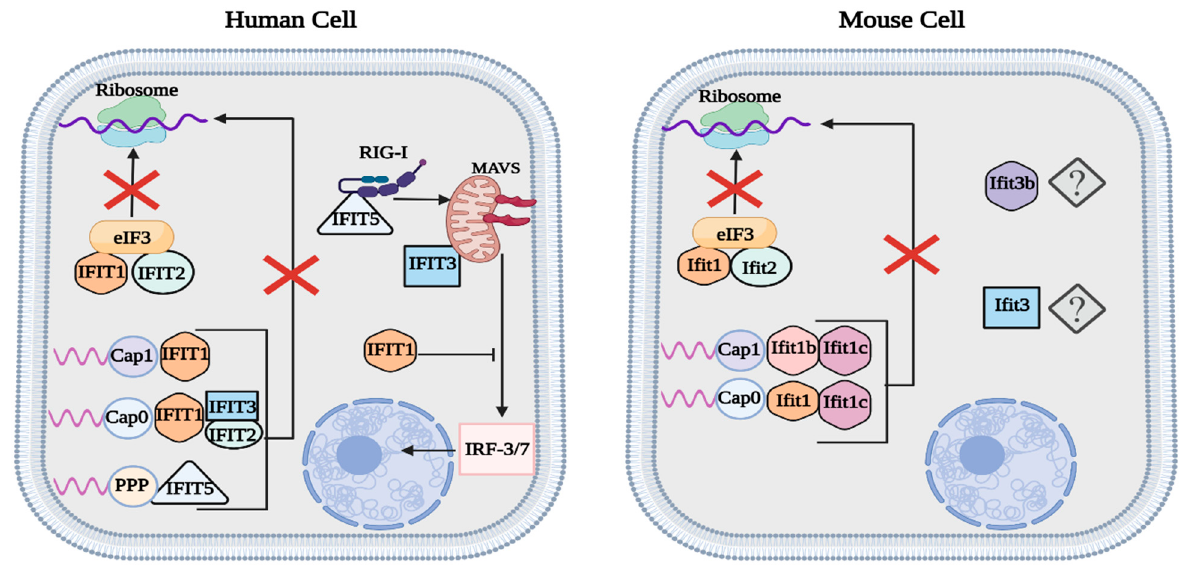
Figure 3. Summary of human and mouse IFIT function. Both human IFIT1/2 and mouse Ifit1/2 reduce viral protein translation by binding to eIF3, thus inhibiting the preinitiation complex. Similar to human IFIT3, mouse Ifit1c enhances the function of other IFIT proteins. IFIT1 is responsible for targeting cap 0/1 RNA in human cells, while mouse cells utilize Ifit1 and Ifit1b to target cap 0 and cap 1 RNA, respectively. IFIT5 binds to phosphorylated RNA and promotes the activity of MAVS. In contrast to IFIT3/5, IFIT1 acts as a negative regulator of the type-I IFN response. The function of mouse Ifit3 and Ifit3b has yet to be fully characterized. This figure was created with BioRender.com (accessed on 20 January 2023).